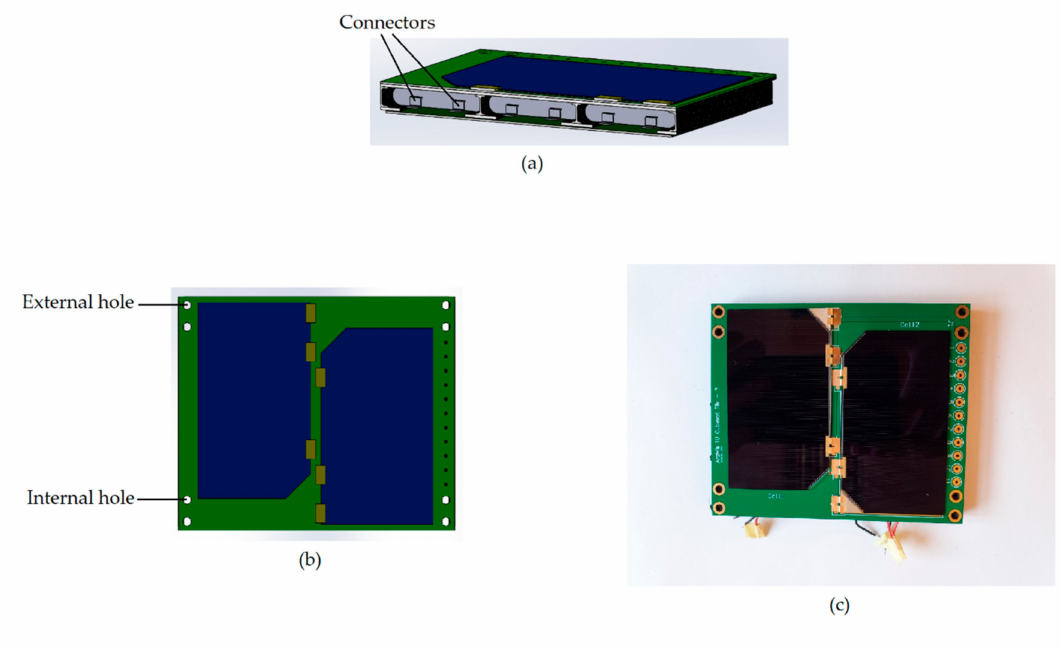
Figure 3. Power management tile: ( a ) CAD model section. The cross-section is colored in white; ( b ) CAD model top view; and ( c ) Experimental model top